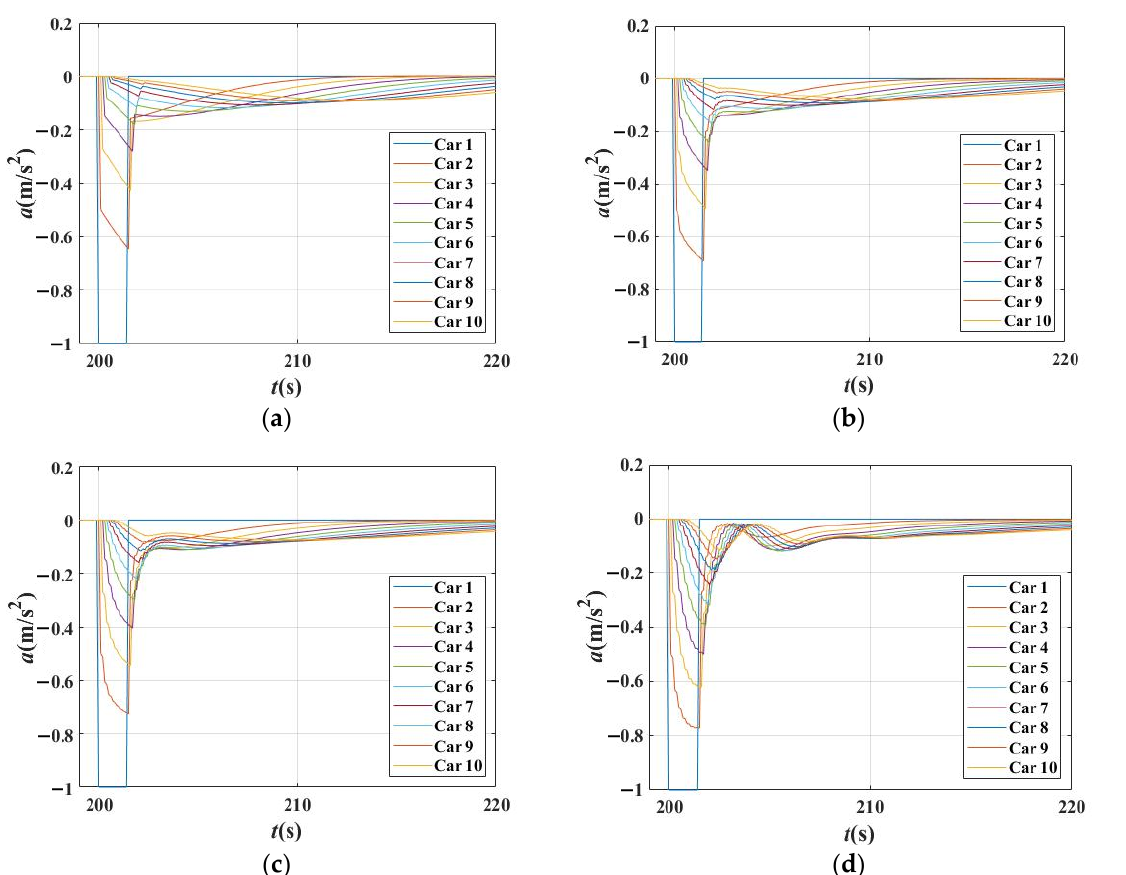
Figure 12. Relationship between the acceleration changes with β 2 when time gap T = 1.5 s in IDM. ( a ) Acceleration changes for each vehicle in platoon when β 1 = 0.5, β 2 = 0; ( b ) Acceleration changes for each vehicle in platoon when β 1 = 0.5, β 2 = 0.2; ( c ) Acceleration changes for each vehicle in platoon when β 1 = 0.5, β 2 = 0.3; ( d ) Acceleration changes for each vehicle in platoon when β 1 = 0.5, β 2 = 0.4.